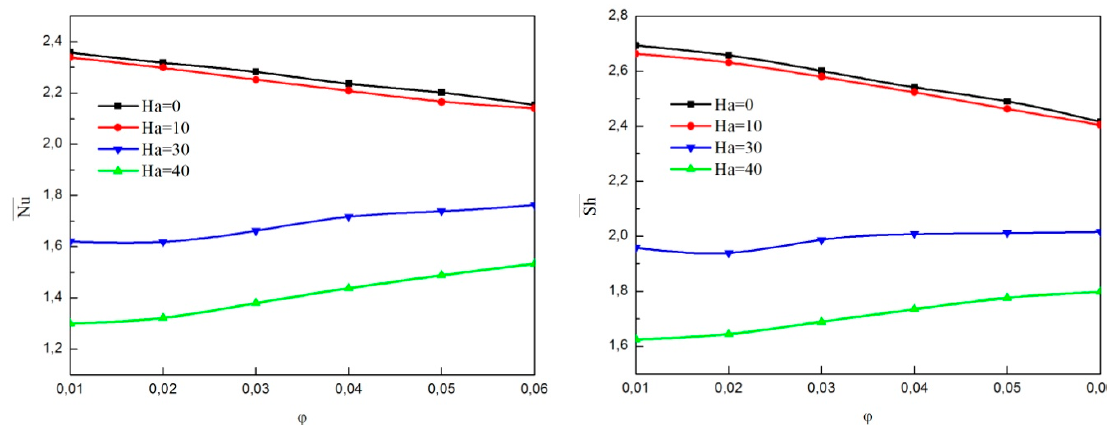
Figure 17. Variations of Nu(cid:3364)(cid:3364)(cid:3364)(cid:3364) and Sh(cid:3364)(cid:3364)(cid:3364) according to the nanoparticles volume fraction for different Hartmann numbers for Ra = 10 5 , K = 1 and N = − 0.5.